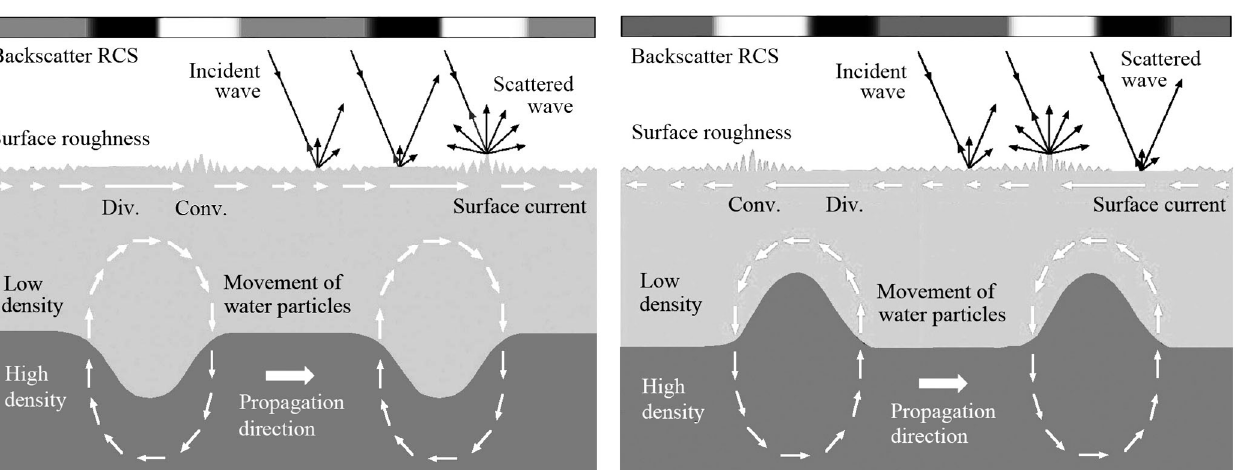
Figure 10. Different image signatures of nonlinear internal waves [63]. Top left and bottom right : TerrasAR–X images over the Gulf of Main west of Cape Cod acquired, respectively, on the 23rd of June and 3rd of July, both in 2008. Top right : ERS–1 SAR image over the Mozambique Channel acquired on the 24th of September 2001. Bottom left : ENVISAT–ASAR image over the Andaman Sea acquired on the 18th of November 2006. The propagation direction is from right to left, except the ENVISAT–ASAR image, in which the interaction can also be seen between the two wave packets propagating predominantly from left to right. Another mechanism associated with ocean wind and surface films is biogenic oil [62,63,73,74]. The imaging processes shown in Figure 9 are under the condition of clean sea surface under moderate wind speed. If the biogenic oil is present on the varying cur- rents induced by IWs, the oil is concentrated in the current convergence zone. Since oil slicks have higher viscosity than seawater, they damp the small–scale Bragg waves.